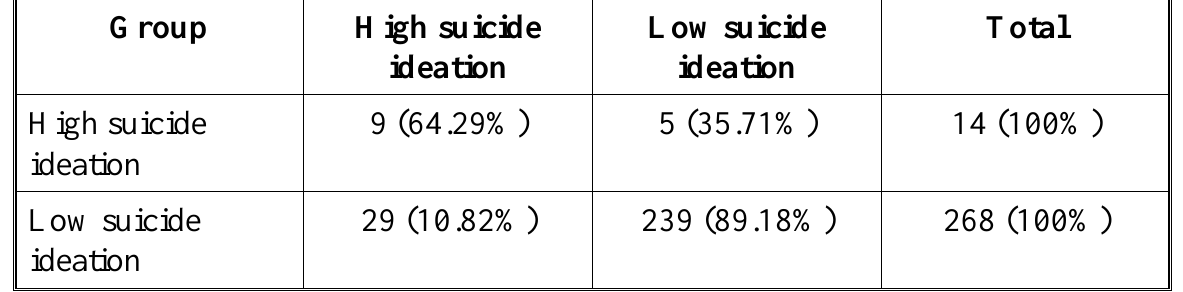
Classification of membership of high/low suicide ideation groups Group High suicide